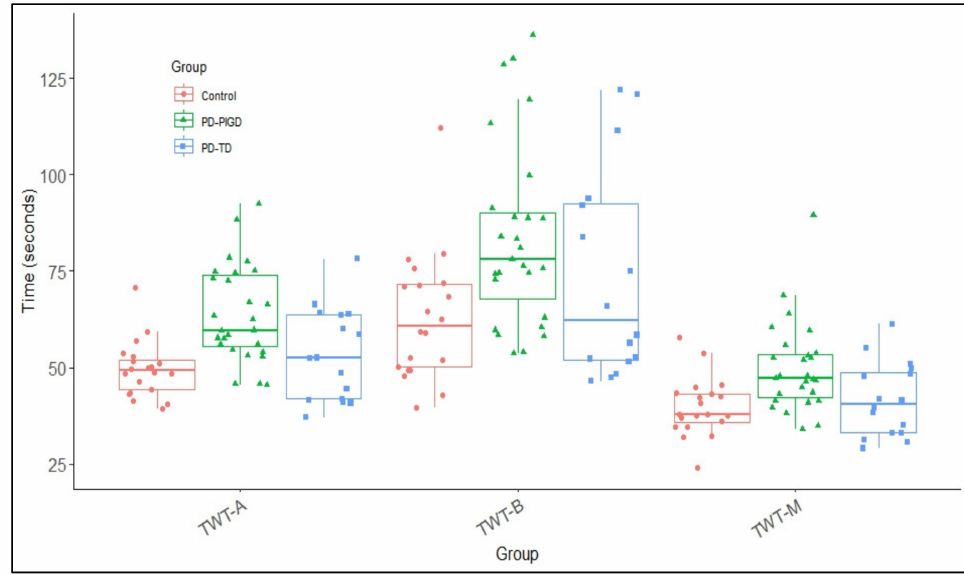
Figure 1. Mean and standard deviation of groups (PIGD, TD & control) and TWT conditions (TWT-A, TWT-B & TWT-M) based on times.